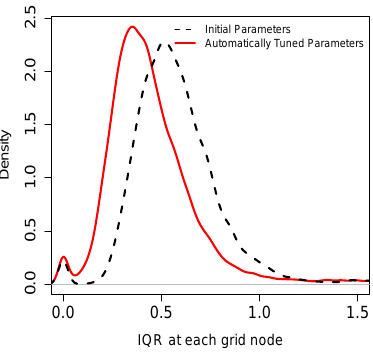
Figure 6. Evolution of the distributions of the IQR values calculated at each grid node. Mean of the IQR values dropped from 0.60 to 0.47 in automatically found parameters.